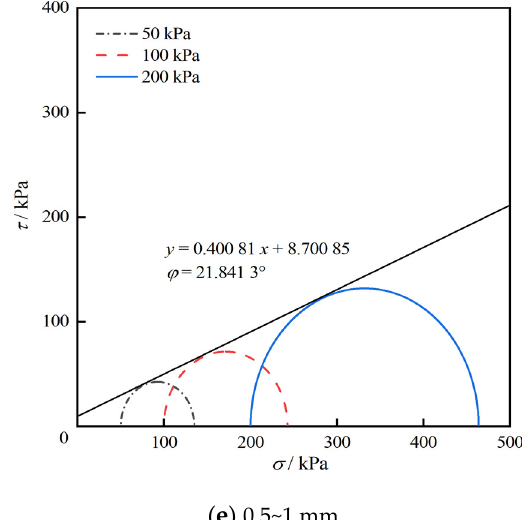
Figure 11. Stressed Mohr circle. Based on the inclination and slope of each intensity envelope, the intensity parame- ter values for the above five different particle sizes are obtained, as shown in Figure 12. The left axis represents the cohesion, the right axis represents the internal friction Angle, and the horizontal axis represents the particle size range.